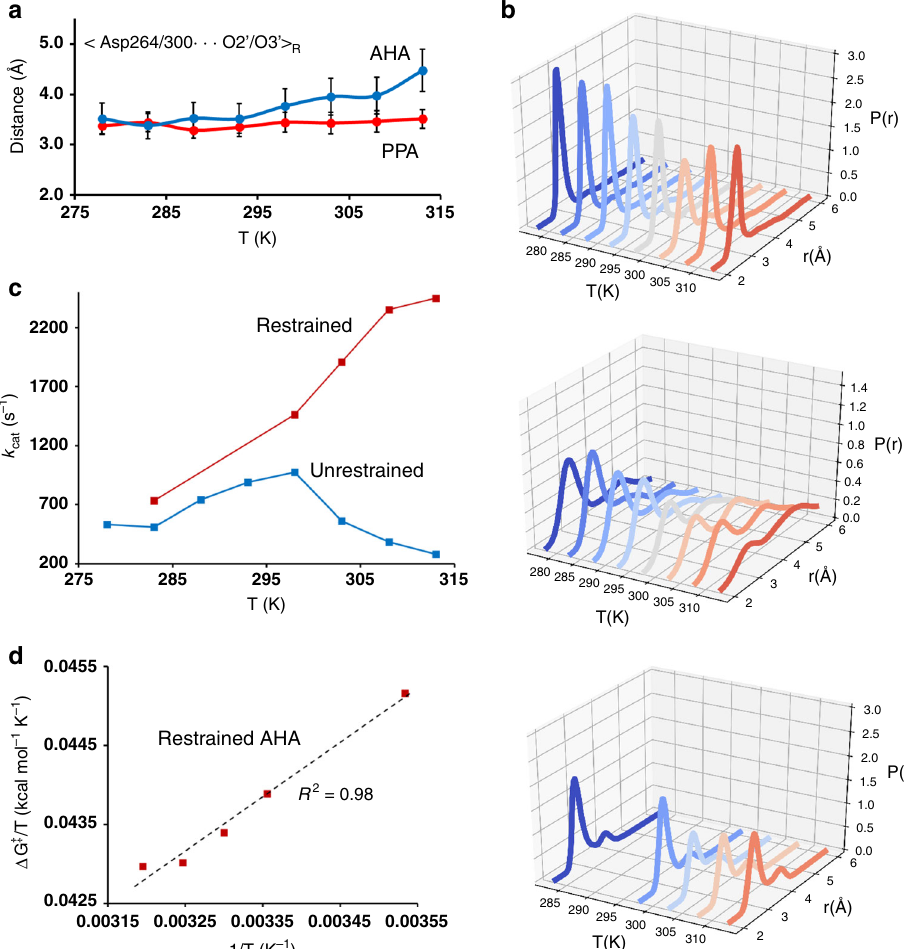
Fig. 5 Origin of the anomalous temperature dependence of AHA. a Average distance between the carboxylate oxygens of Asp264/300 and the two substrate oxygens O2 and O3 of the − 1 glucose unit, as a function of temperature. The curves for Asp264 in AHA and Asp300 in PPA are shown in blue and red, respectively (error bars 1 s.e.m.). b Probability density of the closest Asp264/300 – substrate oxygen (O δ 2 – O2) distance as a function of temperature for PPA (top), AHA (middle), and the restrained AHA simulations (bottom). c Calculated temperature dependence of k cat for AHA with (red) and without (blue) restraints applied to the Asp − COO − ···O2/O3 interaction distance. d Arrhenius plot of Δ G ‡ / T vs. 1/ T for the AHA simulations with distance restraints applied (s.e.m. for free energy barriers is 0.06 – 0.10 kcal mol − 1